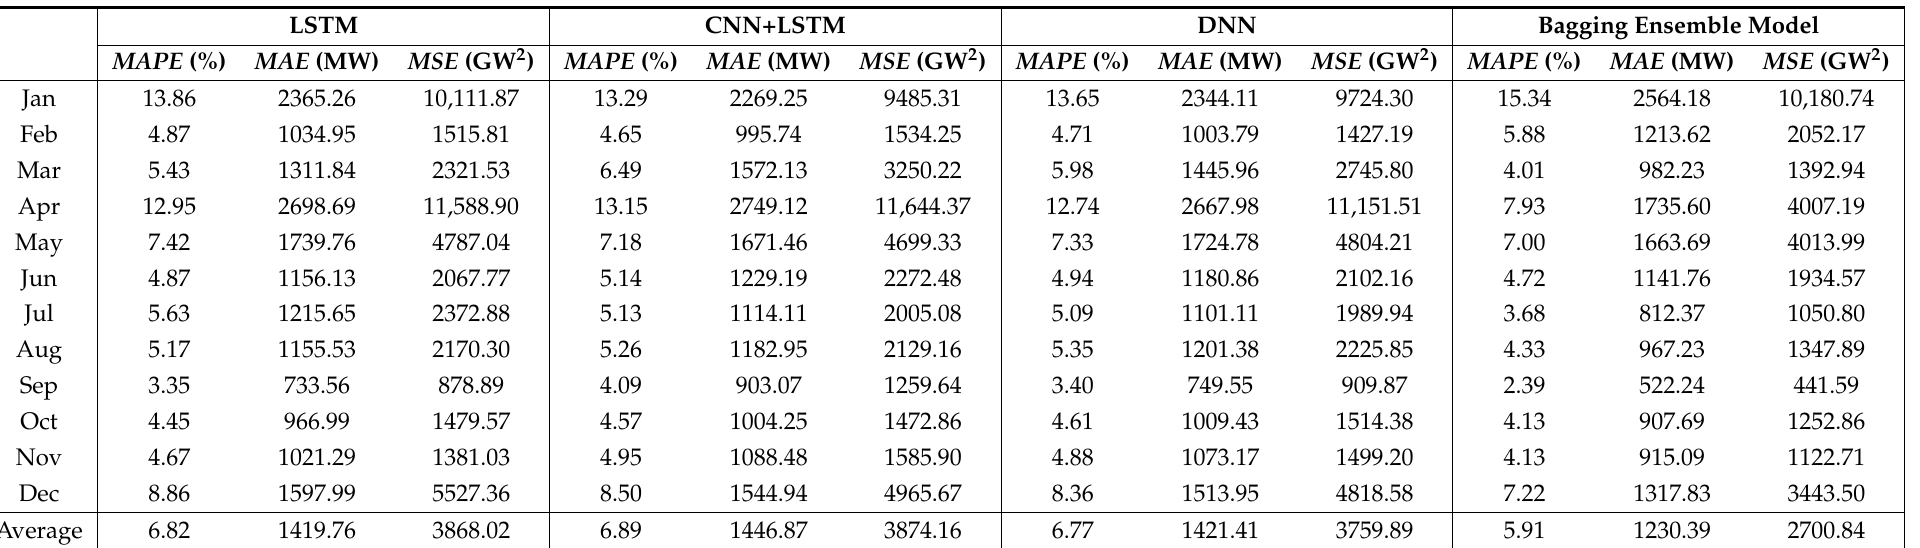
Table 4. Error Measurements of Test Data for Nine Input Features in